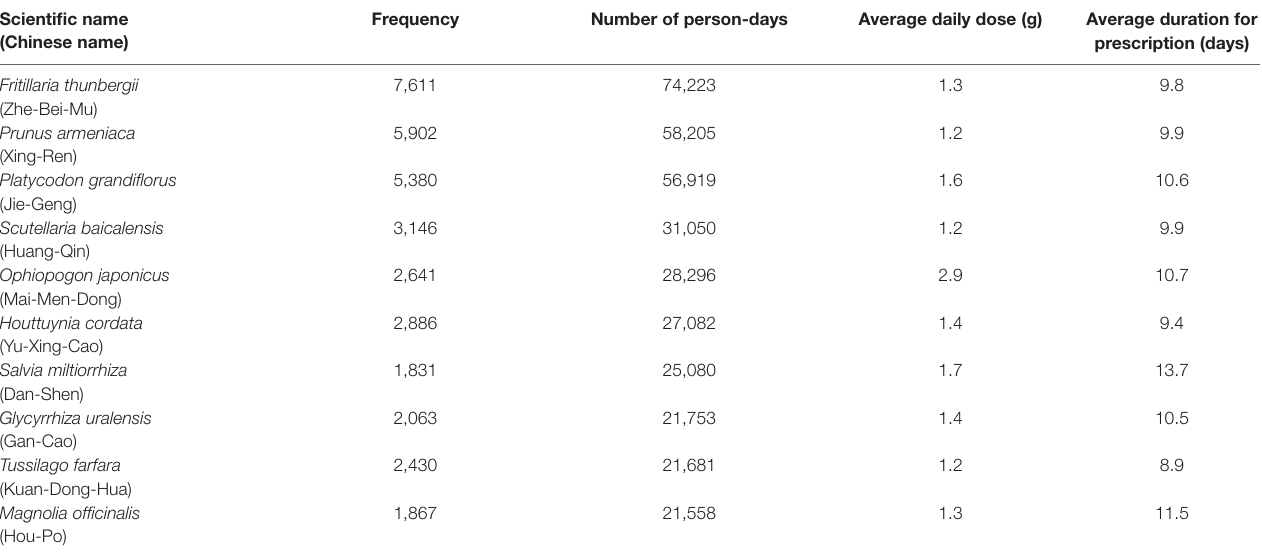
TABLE 3 | Ten most common herbs prescribed for patients with COPD.